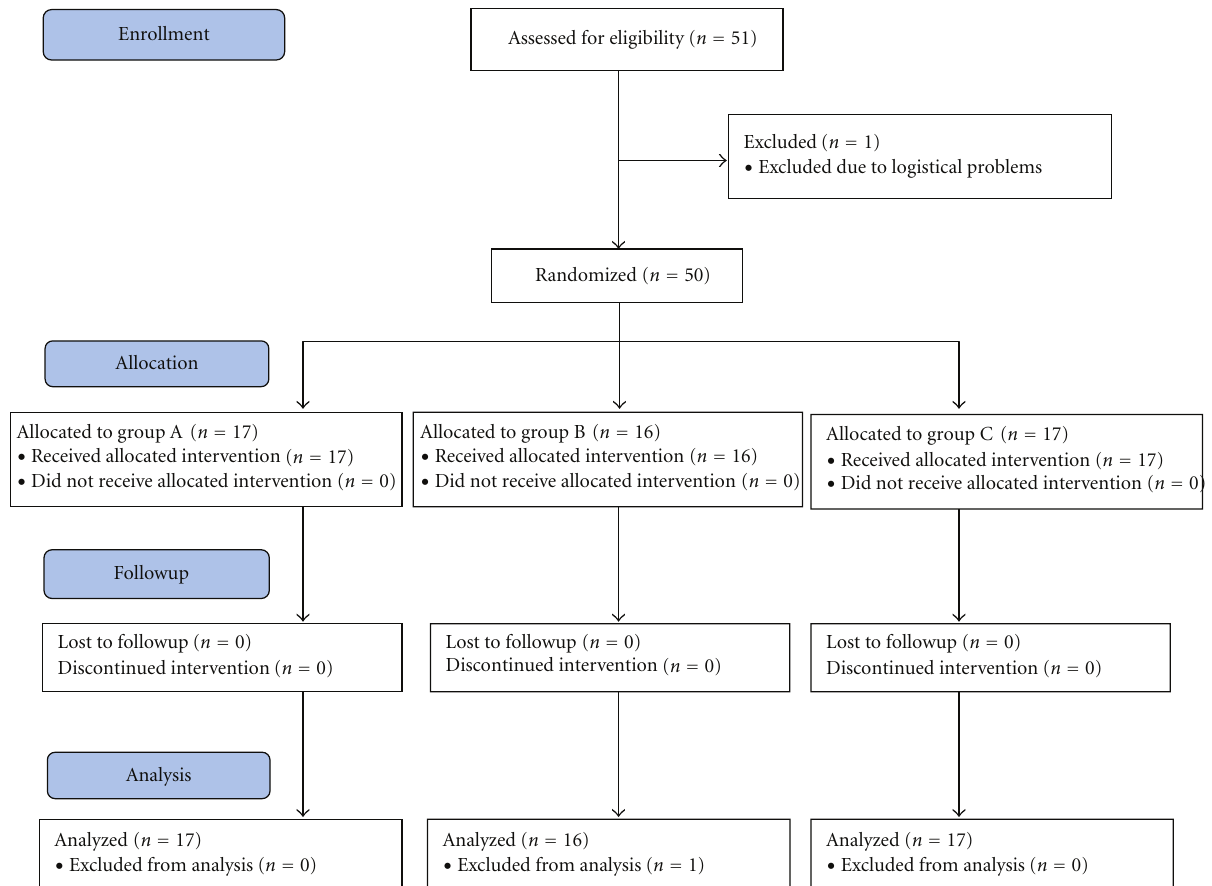
Figure 1: CONSORT diagram of enrollment, allocation, follow-up, and data